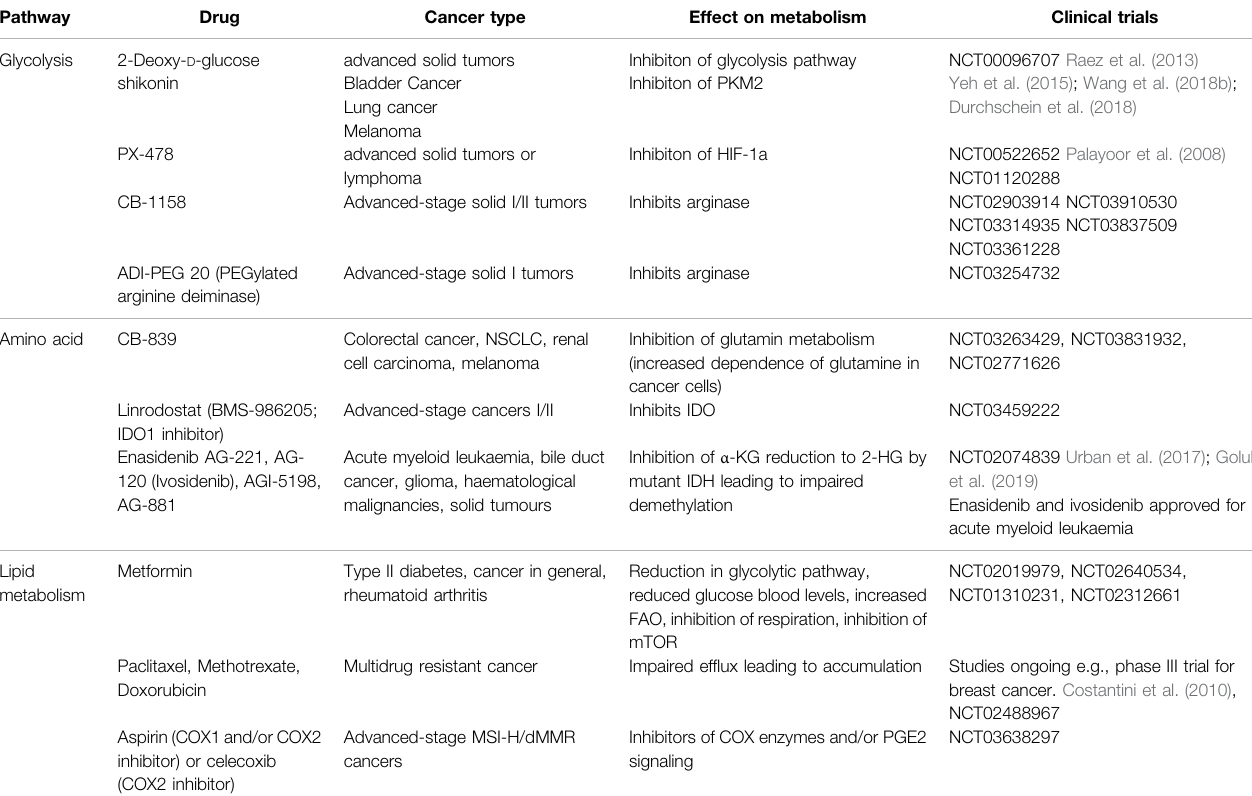
TABLE 1 | Metabolic modulators in clinical